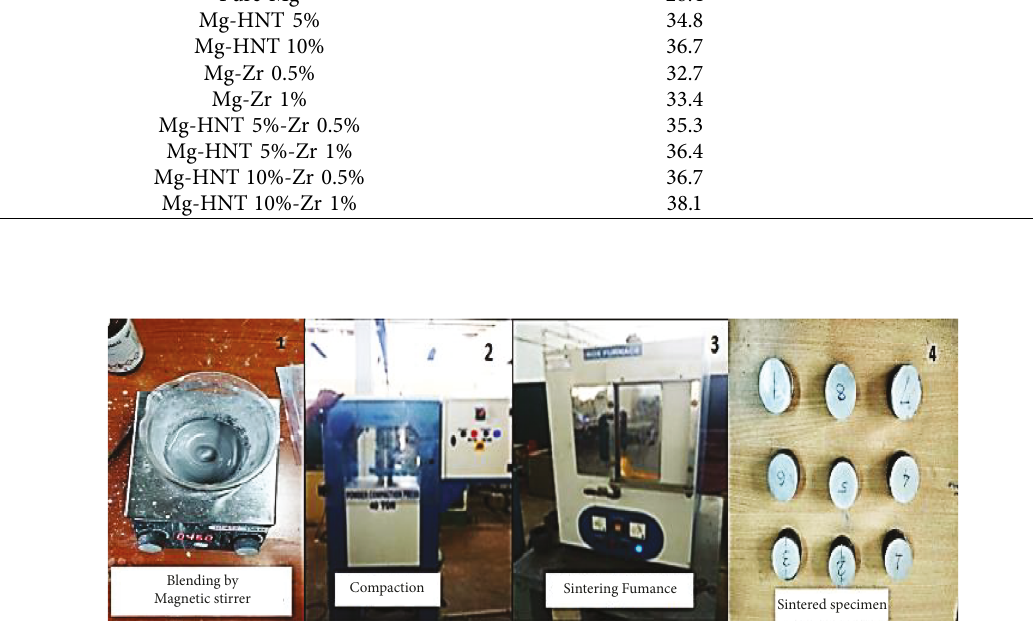
Figure 2: Composite development steps and prepared specimens.